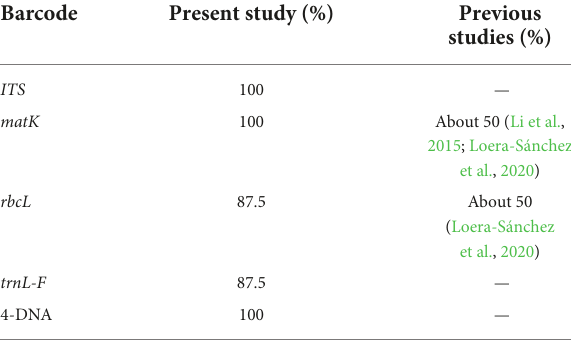
TABLE 6 Species-level assignment success by